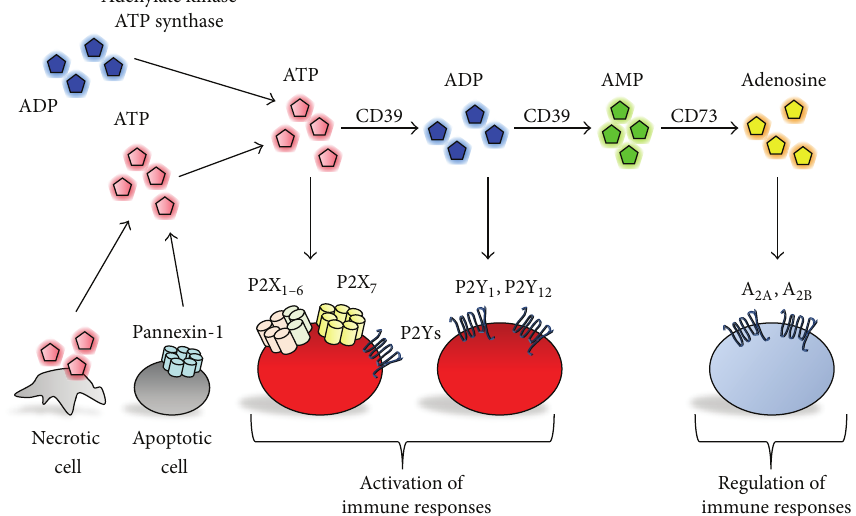
Figure 1: ATP is released from necrotic and apoptotic cells as extracellular ATP (eATP). Also, adenylate kinase and synthase mediate the generationofATPintheextracellularcompartment.Extracellularpurines(e.g.,ATPandADP)stimulatetheirreceptorsandmodulatevarious biological processes. Once eATP is released, the ATP is soon hydrolyzed to AMP and adenosine by the ectonucleotidases CD39 and CD73. , A 2 , and A 3 Adenosine binds to adenosine receptors (e.g., A 1 , A 2 A B